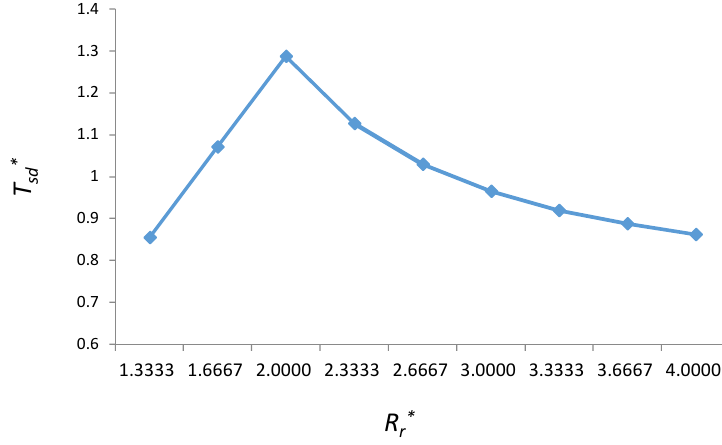
Figure 14. Influence of dimensionless air resistance on dimensionless suction duration.